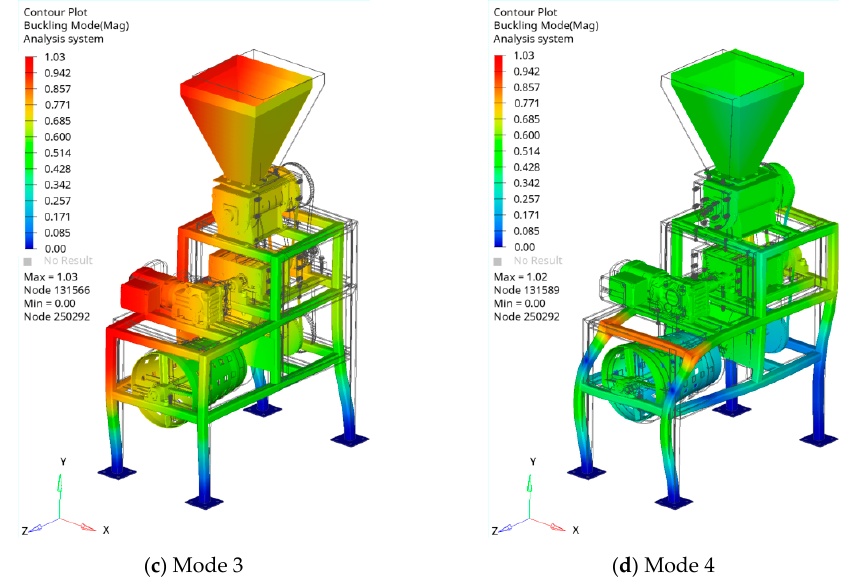
Figure 22. Principal buckling modes shapes; ( a ) First; ( b ) Second; ( c ) Third and ( d ) Fourth buckling mode shape.